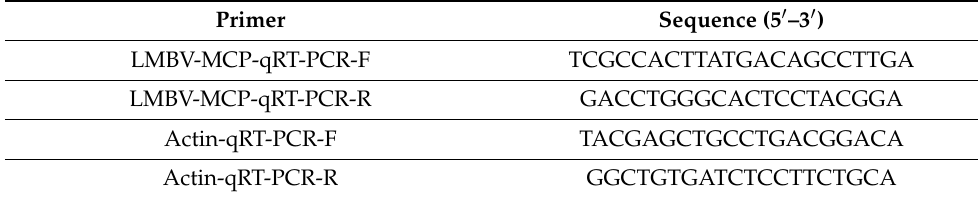
Table 1. Primer sequences used in this study.